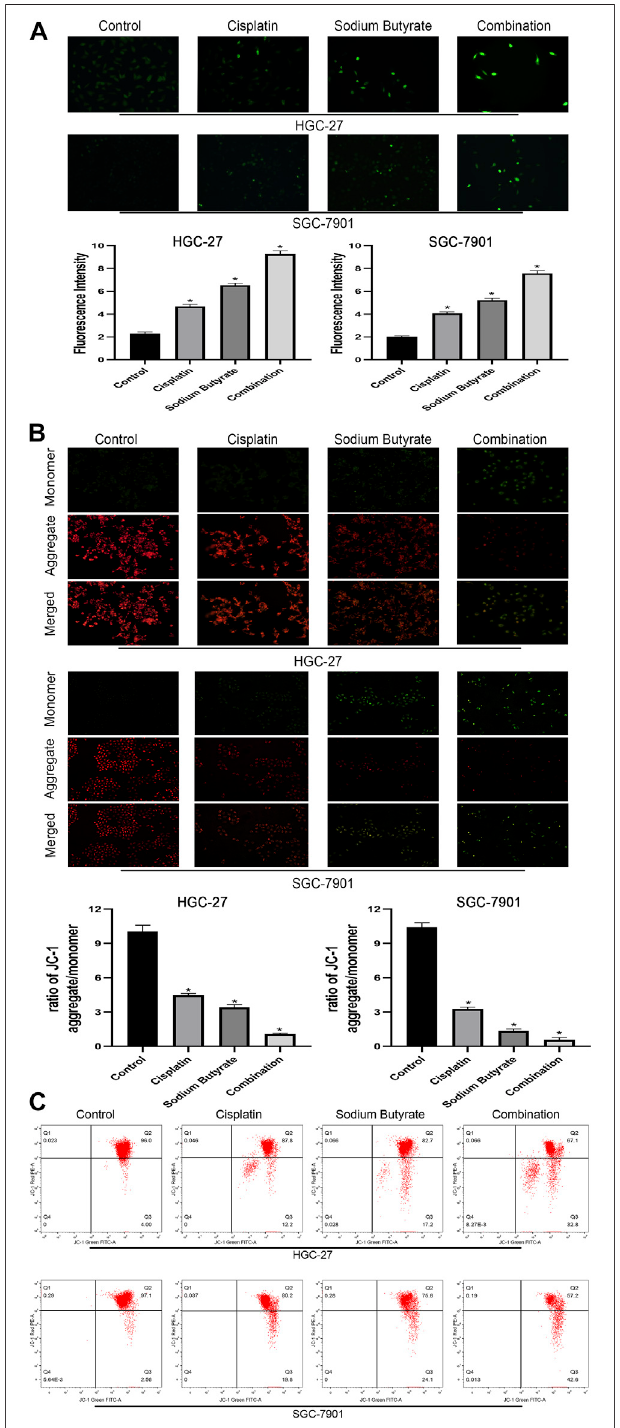
FIGURE4 |analysisofROSineachgroup.* p < 0.05vsthecontrolgroup. ((B) and (C)) Cells were incubated with control, cisplatin, sodium butyrate, or cisplatin + sodium butyrate described in (A) above. MMP was observed via JC-1 staining. Red in fl orescence indicates healthy mitochondria; green in fl orescence indicates collapsed mitochondrial potential. Quantitative analysis of the MMP in each group. * p < 0.05 vs the control group. All the above data are the mean ± SD from an average of three